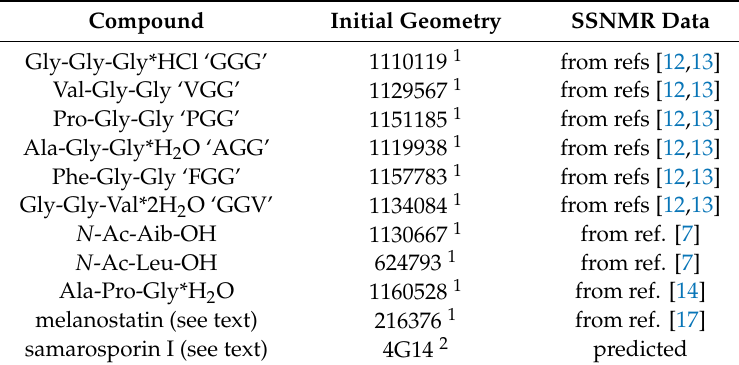
Table 1. Peptides investigated in this